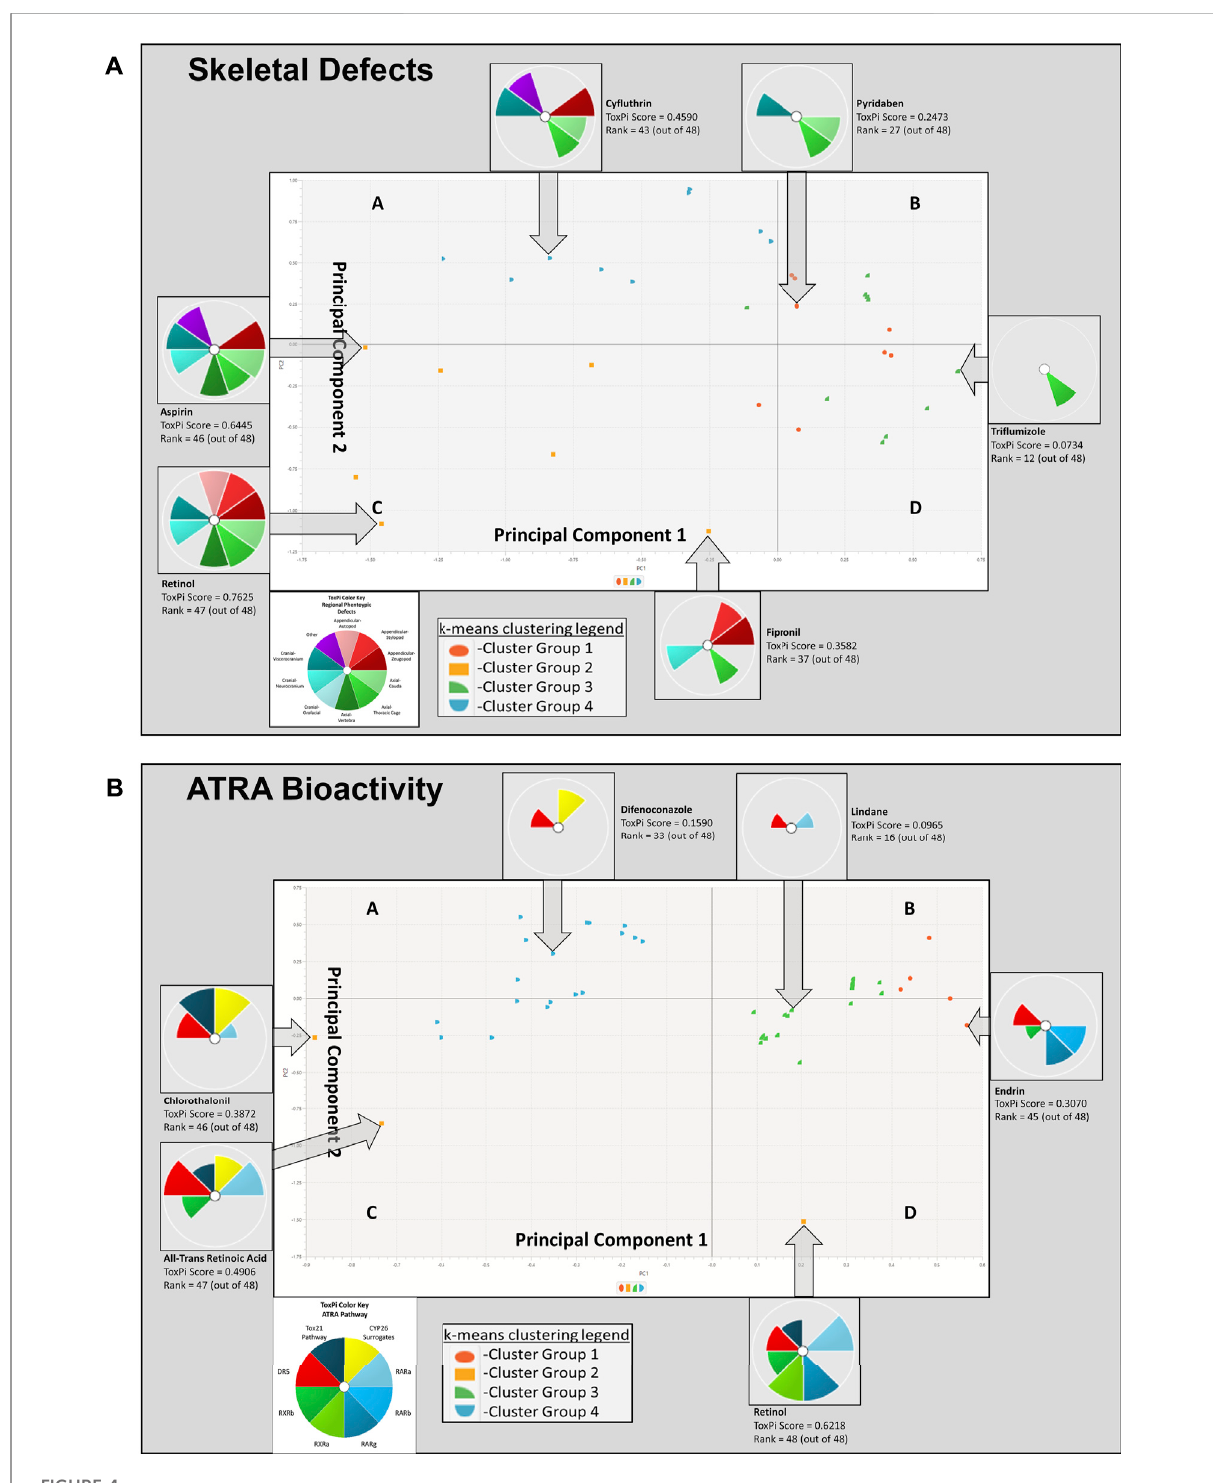
FIGURE 4 K-means clustering of Skeletal Defects (A) and ATRA Bioactivity (B) for 48 chemicals. In image A, skeletal defects examined include autopod, stylopod, zeugopod, cauda, thoracic cage, vertebra, orofacial, neurocranium, viscerocranium, and other. Principal Component 1 (PC1), the x-axis, identi fi es variability in the 48 model chemicals, indicating heterogeneity in the skeletal response. Moving from left to right, a broader range of phenotypicchanges are found, and then thearray ofskeletalresponses diminishes with horizontal progression. The left sidePC1demonstrates lessspeci fi city,whiletherightsidehasmorespeci fi city(i.e.,singlethoraciccageslice).Thisisdemonstrablebytheleftmostclustergroup2havingthe